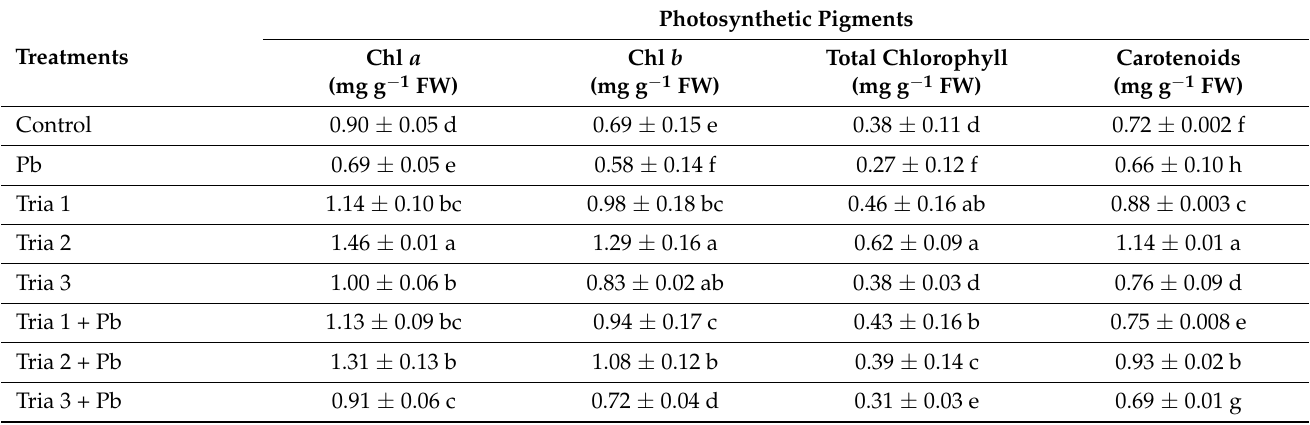
Table 3. Effects of Triacontanol and Pb on Photosynthetic Pigments of Phaseolus vulgaris L.